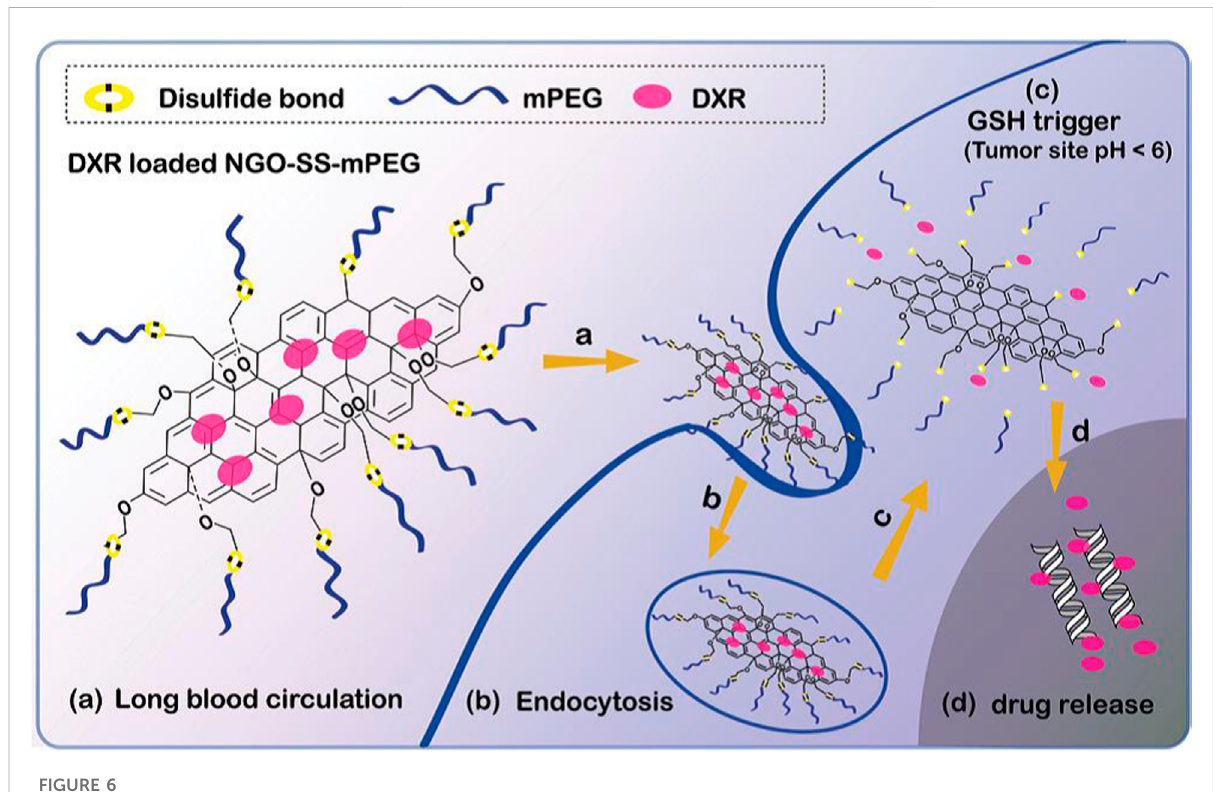
FIGURE 6 Schematic diagram showing antitumor activity of redox sensitive DXR-loaded NGO-SS-mPEG.